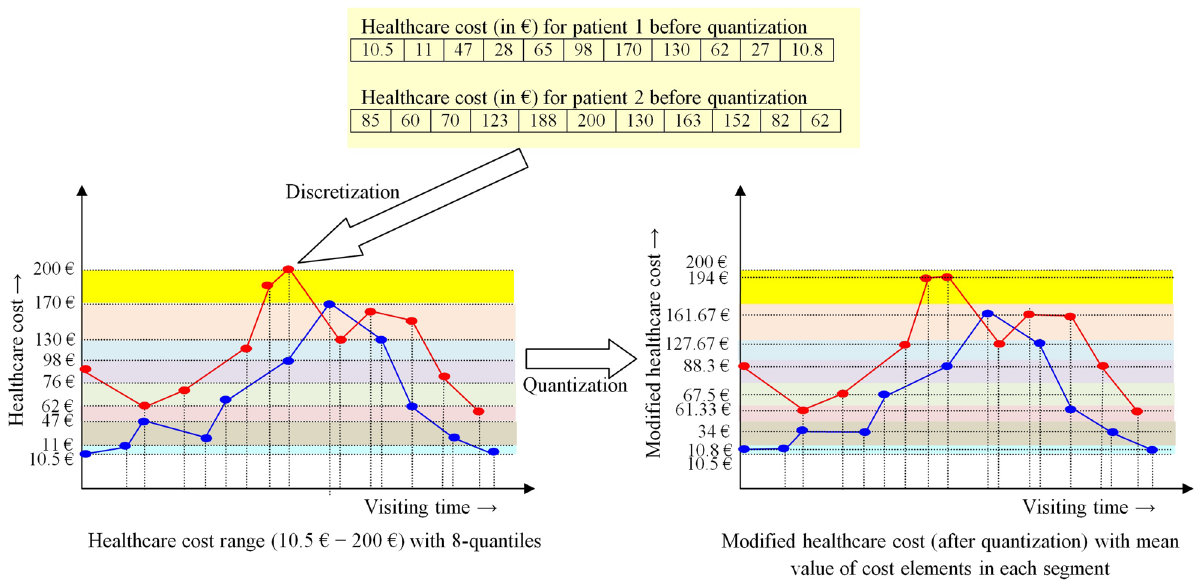
Figure 1. Calculation of modified healthcare cost of two patients with